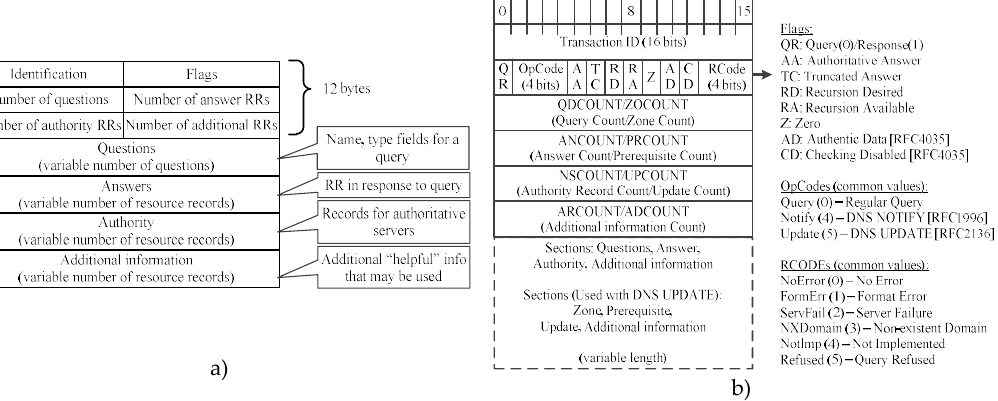
Figure 11. DNS message format (a) and the flag field in the DNS header (b).